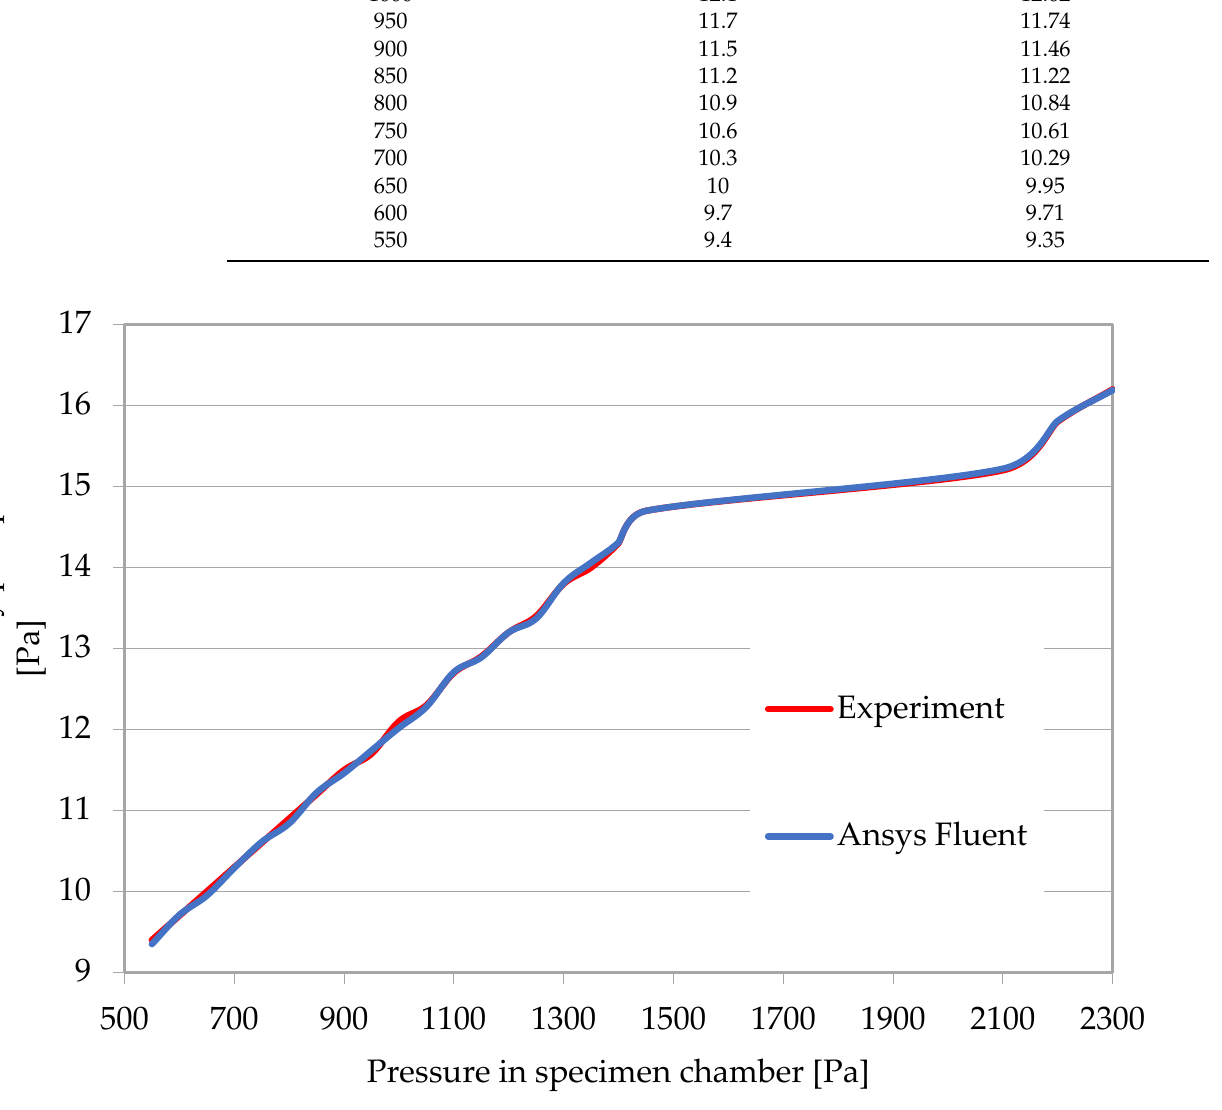
Figure 4. Comparison of differentially pumped chamber pressures obtained from experimental measurements and Ansys Fluent analyses.